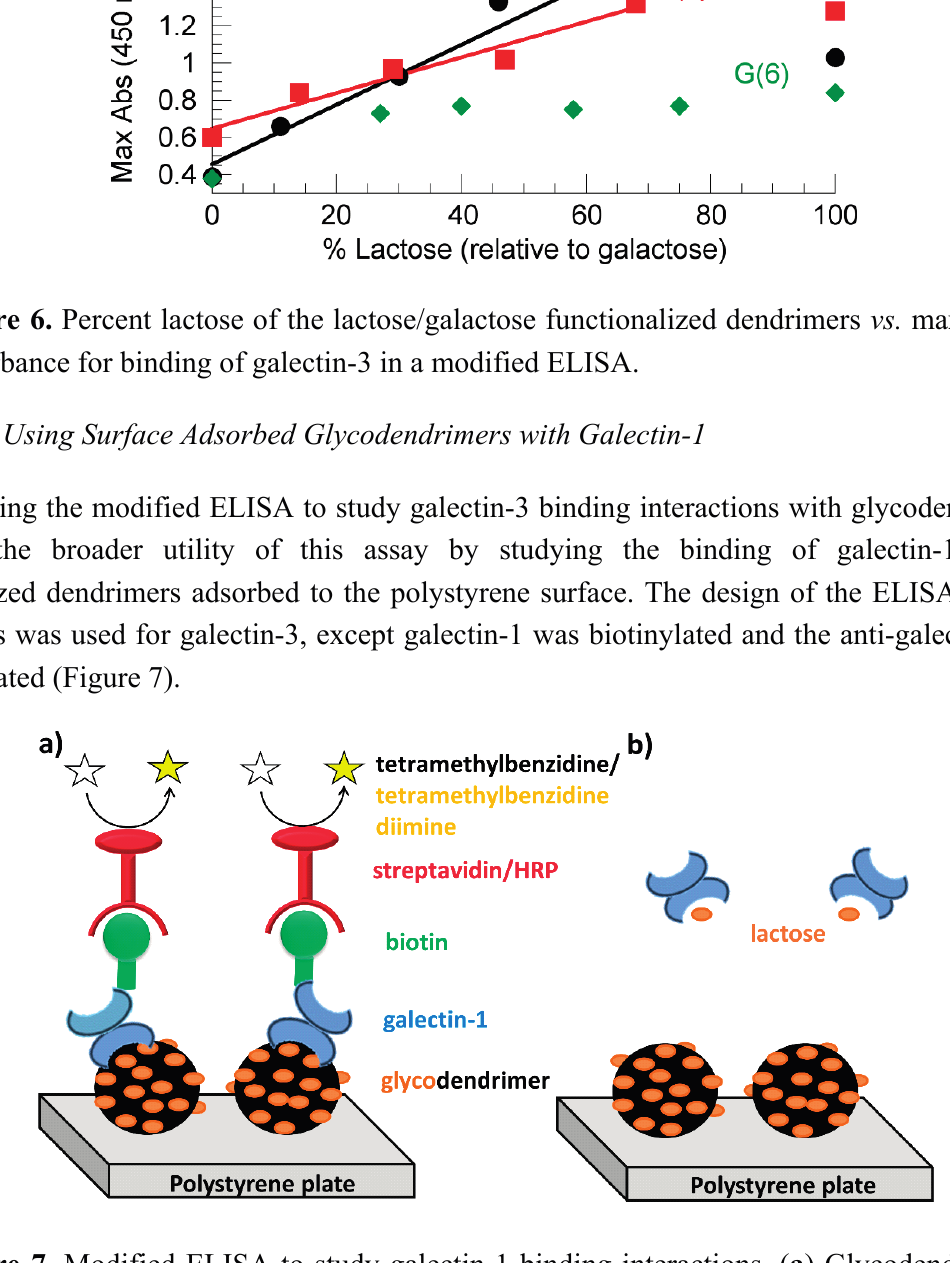
Figure 7. Modified ELISA to study galectin-1 binding interactions. ( a ) Glycodendrimers were adsorbed to the surface of a plate, and biotinylated galectin-1 was added to measure binding affinity; ( b ) Monomeric lactose was added to inhibit galectin-1 binding to the glycodendronized